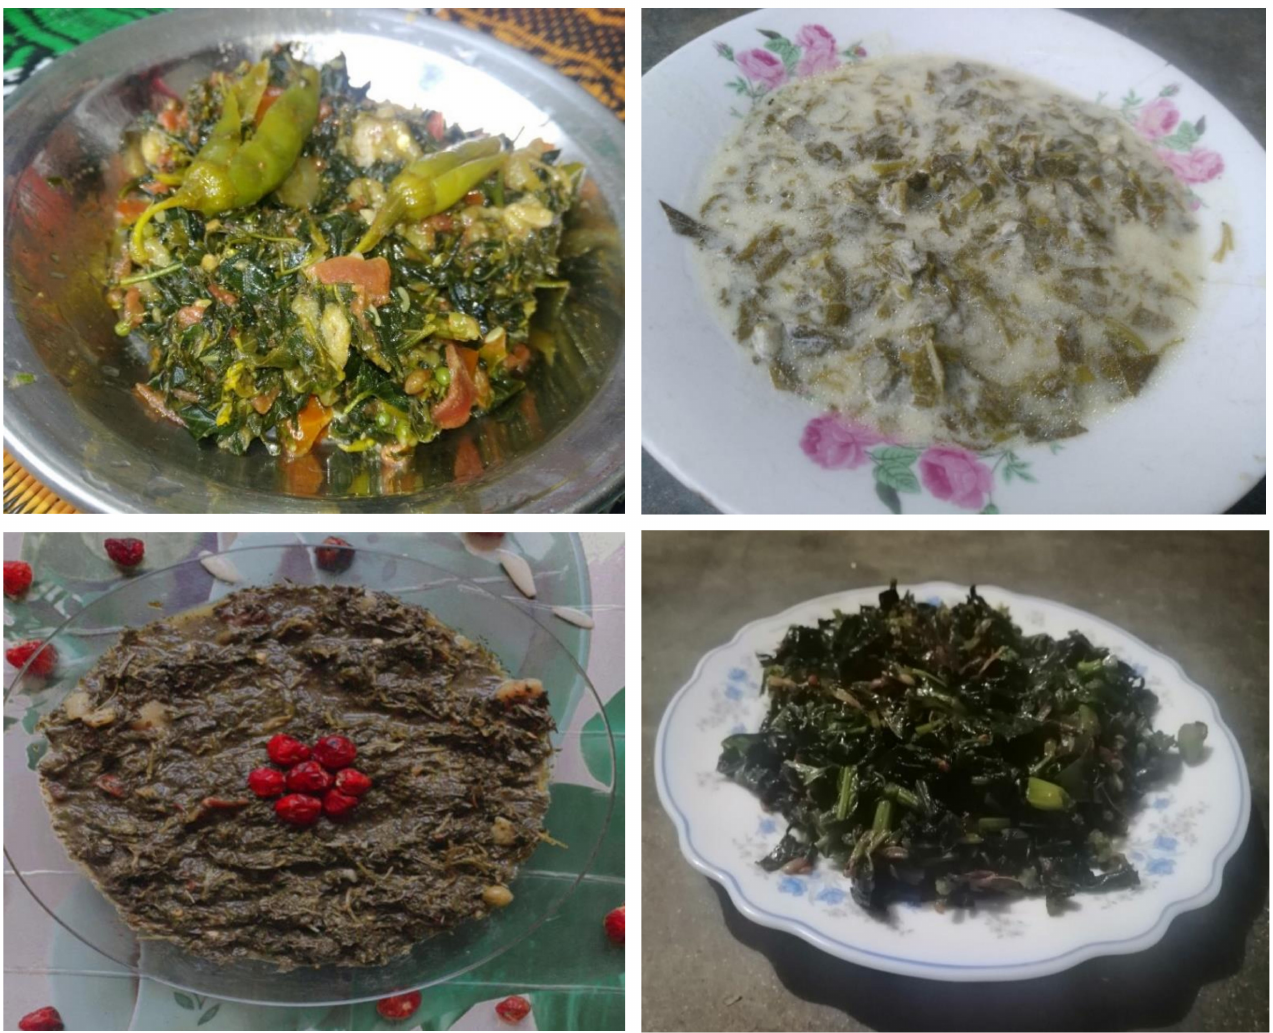
Figure 7. Some wild edible vegetable-based dishes cooked in the homes of the study